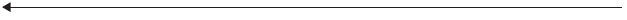
Fig. 5 Changes in PAO1 bio fi lm mechanics associated with changes in EPS expression are measured by taking the ratio of the value for a mutant bio fi lm to the value for the WT bio fi lm. Striped highlights enhanced mechanics and grey highlights diminished mechanics. Error bars are standard error of the mean. ( a ) Increasing the production of Psl or Pel, as seen in Δ wspF Δ psl ( n = 4) , Δ wspF Δ pel ( n = 4) , and Δ wspF ( n = 2), increases bio fi lm toughness. Increasing the production of alginate ( Δ mucA ) has no net effect on bio fi lm toughness ( n = 3). Please note that our measurement of toughness as the energy required to cause the bio fi lm to yield includes both elastic and viscous contributions, while the properties in panels ( b – d ) are all elastic properties. ( b ) Increased production of Psl ( Δ pel ( n = 3), Δ wspF Δ pel ( n = 4), and Δ wspF ( n = 2)) causes bio fi lms to have higher plateau elastic moduli G ' than does the WT bio fi lm. Increased production of alginate reduces plateau value of G ′ . Increased production of Pel without a concomitant increase in